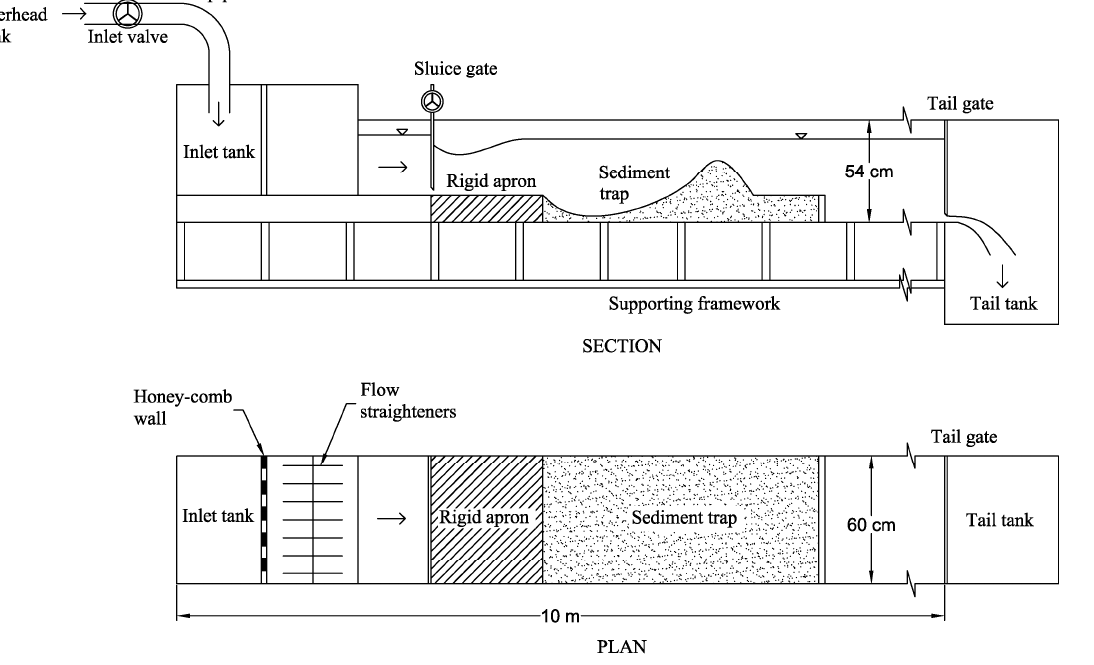
Figure 2. Plan and section of the experimental setup.